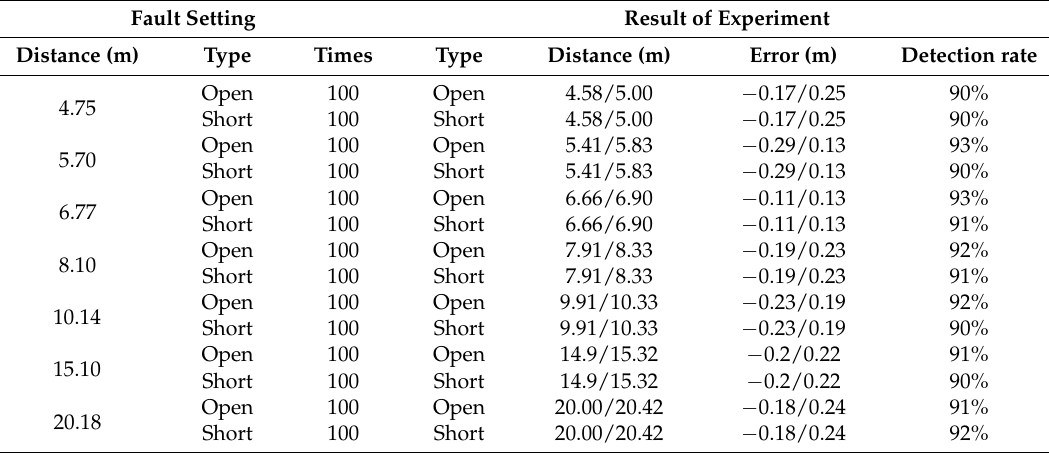
Table 2. Statistical result of